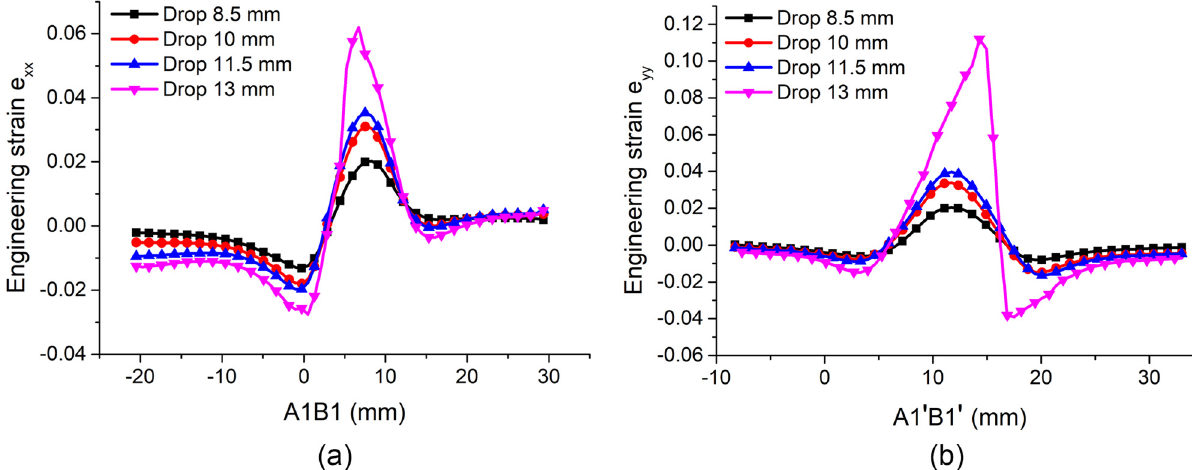
Figure 14: Strain distributions along center line: ( a ) ε xx and ( b ) ε yy .